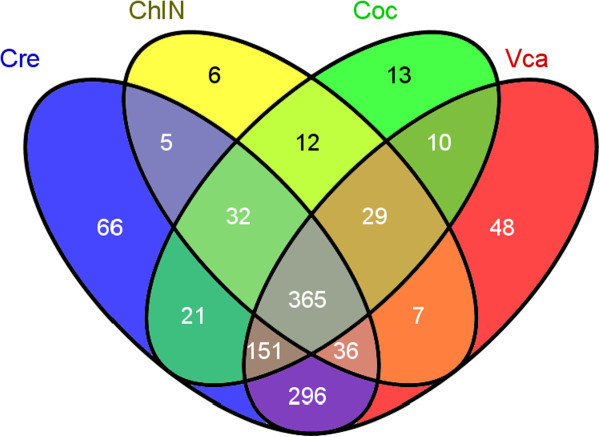
Venn Diagram of the numbers of C. moewusii transcripts with BlastX hits from other four green algae with reference genome sequences. The BlastX cut-off value is 0 for this comparison. Cre: The number of C. moewusii transcripts with BlastX hits to C. reinhardtii; ChlN: The number of C. moewusii transcripts with BlastX hits to C. variabillis N64A; Coc: The number of C. moewusii transcripts with BlastX hits to C. subellipsoidea; and Vca: The number of C. moewusii transcripts with BlastX hits to V. carteri.